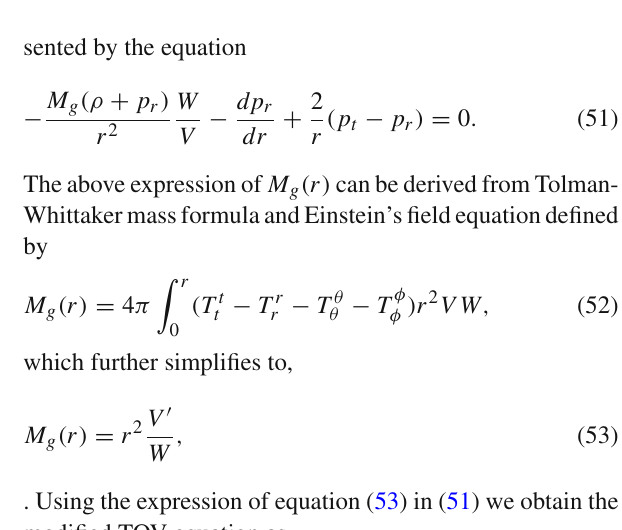
Table 2 The numerical values of the central density ( ρ c ), surface density ( ρ s ), central pressure ( p c ), compactness factor and surface redshift of few well known compact star candidates